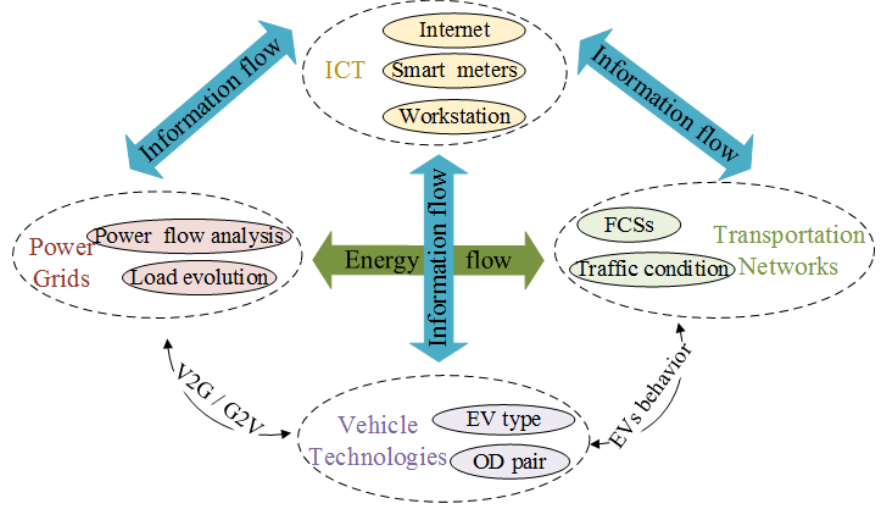
Figure 1. Framework on the interaction of coupled traffic and energy transportation networks (CTETNs).